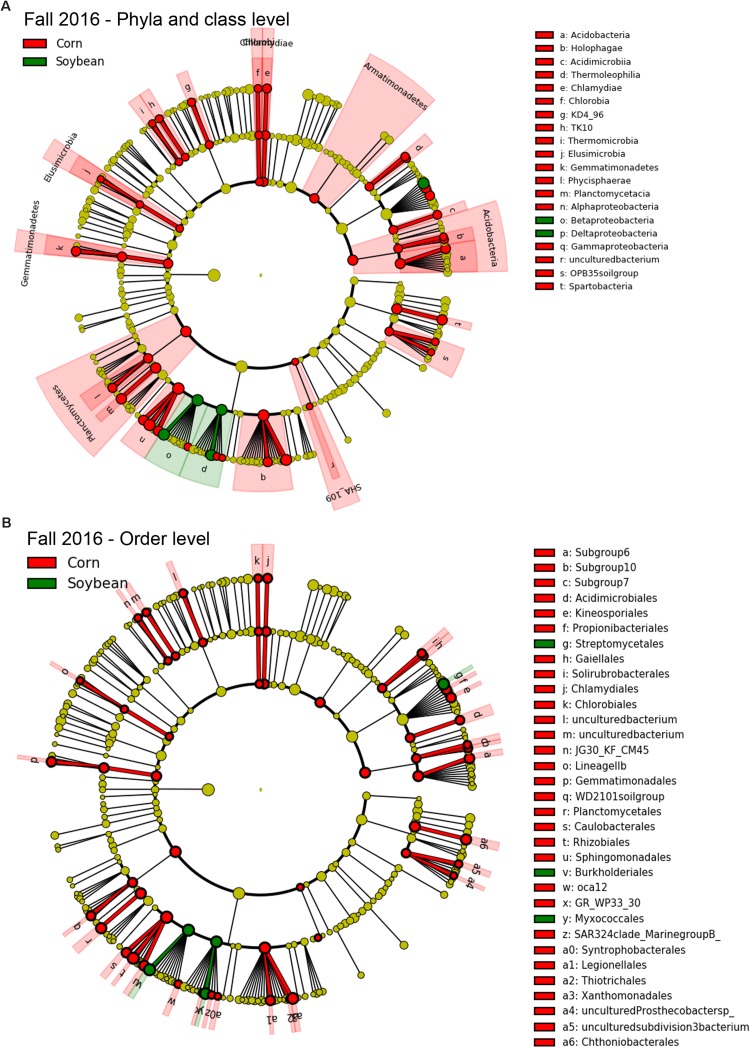
Taxa enriched in cysts of corn and soybean crop sequences identified by LEfSe analysis in fall of 2016. Cladograph shows taxa at different phylogenetic ranks that are significantly discriminant in cysts from soybean (green) and corn (red) crop sequences in fall 2016 at level of both bacterial (A) phyla and classes and (B) orders. The colored wedges indicate phyla/class and orders that are significantly discriminant at that phylogenetic rank. Letters code the specific classes or orders shown in the legend to the right. Smaller colored circles in each ring indicate significantly discriminant taxa at each lower taxonomic hierarchical level below phyum [e.g., order, family, genus, and species (OTU)] within bacterial classes. A full list of taxa used to generate this cladogram is given in Supplementary Table S6.